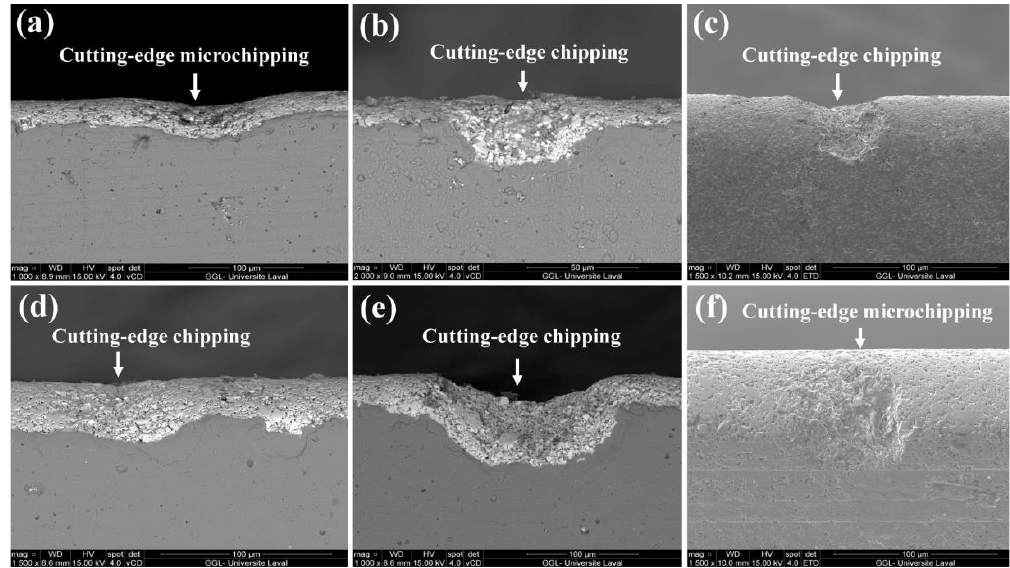
Figure 25. Typical aspect of the cutting edge of tips (rake face view): ( a , d ) saws #2, ( b , e ) saws #4, and ( c , f ) saws #6 after 960 min of sawing.